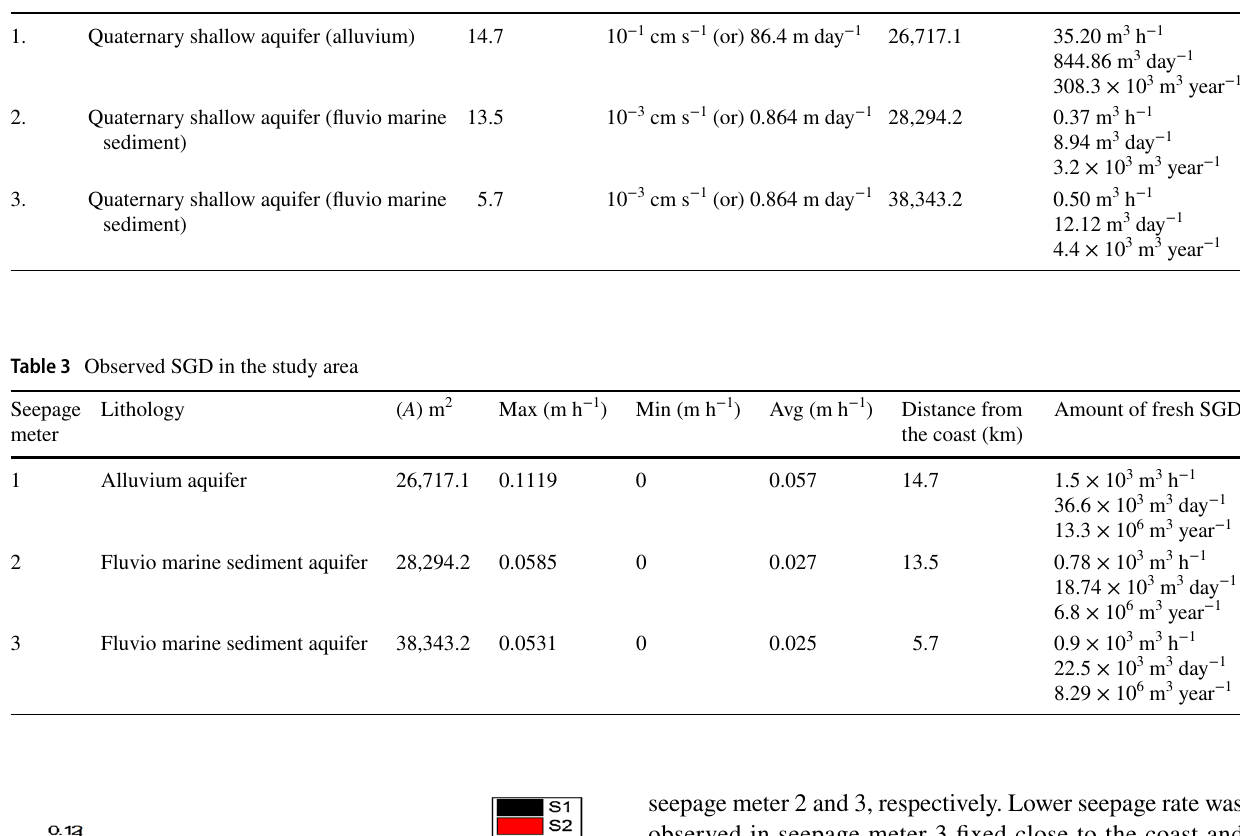
Table 2 Darcy law-calculated SGD for the study area Lithology Distance from Seep- age meter